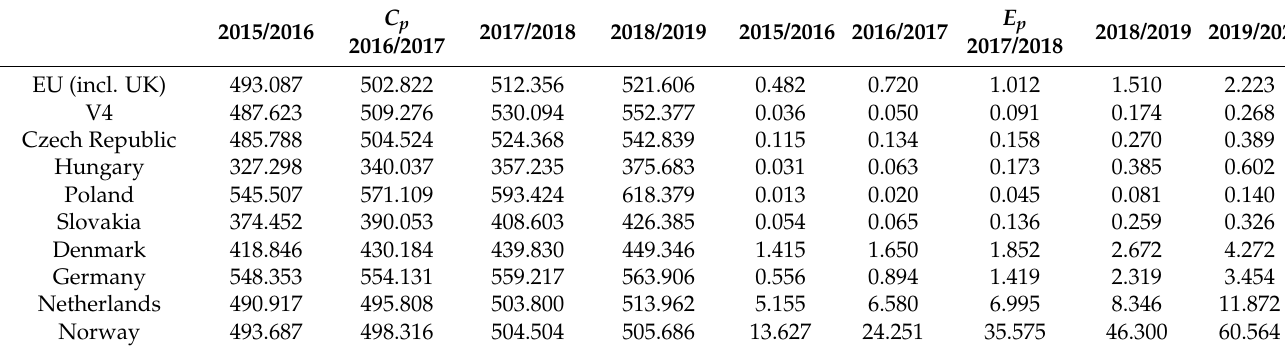
Table 8. The total number of plug-in electromobiles per 1000 inhabitants ( E p ) vs. the total number of passenger cars per 1000 inhabitants ( C p ) at the turn of the years.